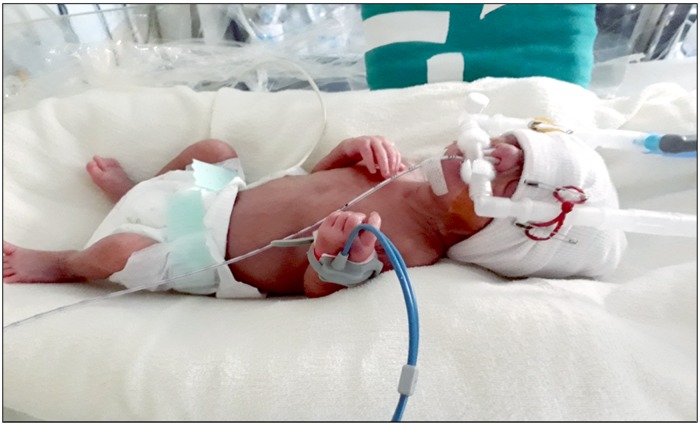
Hudson short binasal prongs.